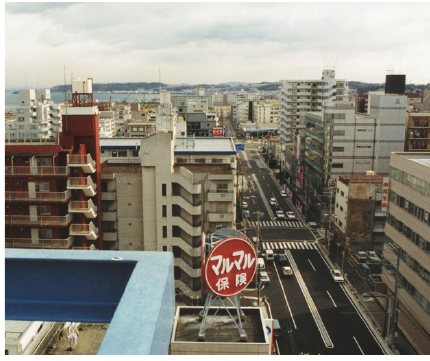
Figure 15: View from the rooftop where the RZL was measured.